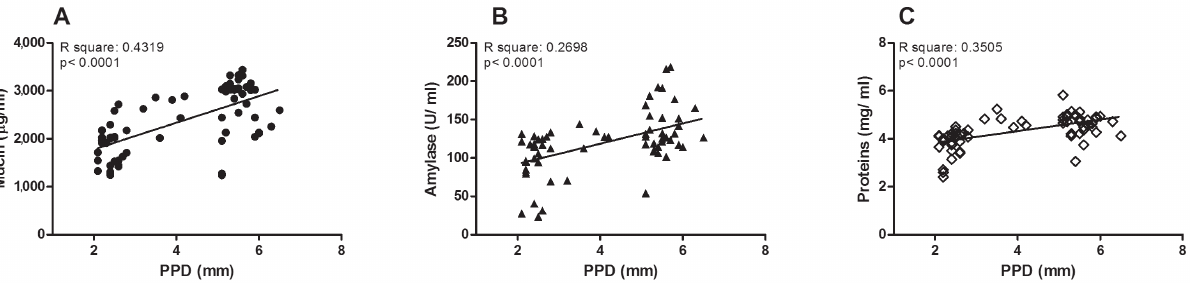
Figure 3- Pearson’s correlation analysis between mucin (A), amylase (B) and proteins (C) and probing pocket depth (PPD) in the entire subjects studied